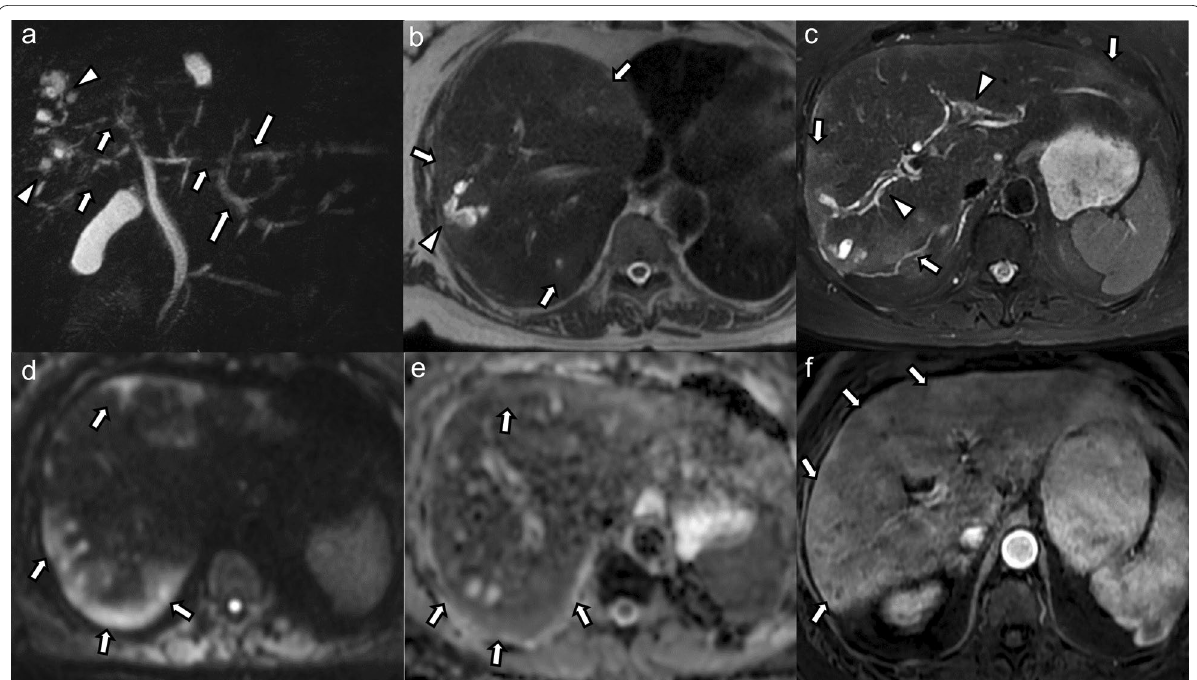
Fig. 2 69-year-old male patient with COVID-19-associated SSC complicated by acute bouts of cholangitis with development of multiple biliary abscesses requiring prolonged antibiotic and interventional therapy. a Maximum intensity projection MRCP image shows multifocal areas of bile duct stricturing (arrows) in both liver lobes with intermittent mild upstream dilatation (long arrows). In the right liver lobe, there are clustered cystic changes representing saccular dilatation of bile ducts (arrowheads). b Axial non-fat-suppressed and ( c ) fat-suppressed T2-weighted images show multiple patchy hyperintense parenchymal changes in the periphery and subcapsular liver (arrows in b and c). Saccular dilatation of peripheral bile ducts (arrowhead in b ) with intraluminal debris. There are hyperintense peribiliary signal changes (arrowheads in c ). d High b -value diffusion-weighted images and ( e ) corresponding ADC map again show these peripheral and subcapsular signal changes with mild diffusion restriction (arrows). f On post-contrast arterial phase images these parenchymal changes are hyperenhancing